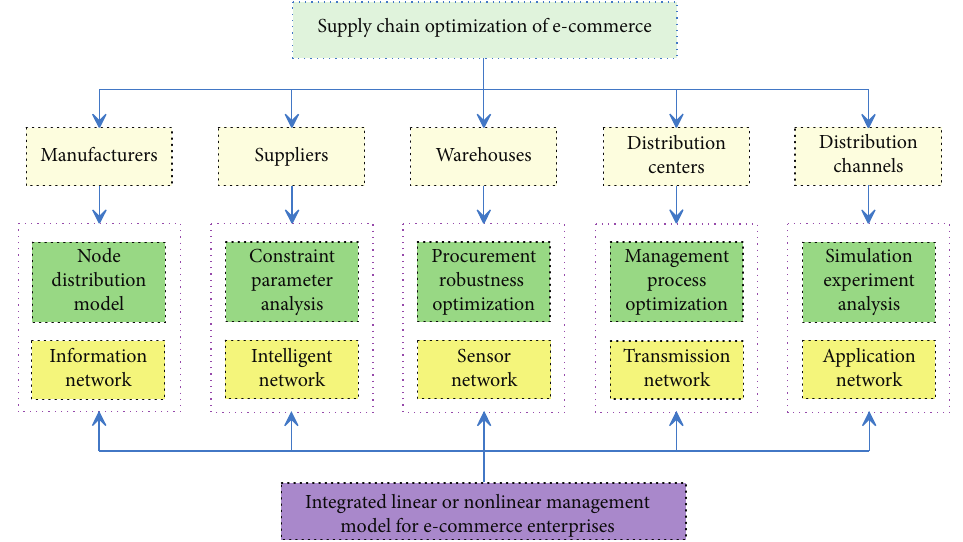
Figure 3: Optimization design for IoT-based e-commerce supply chain.